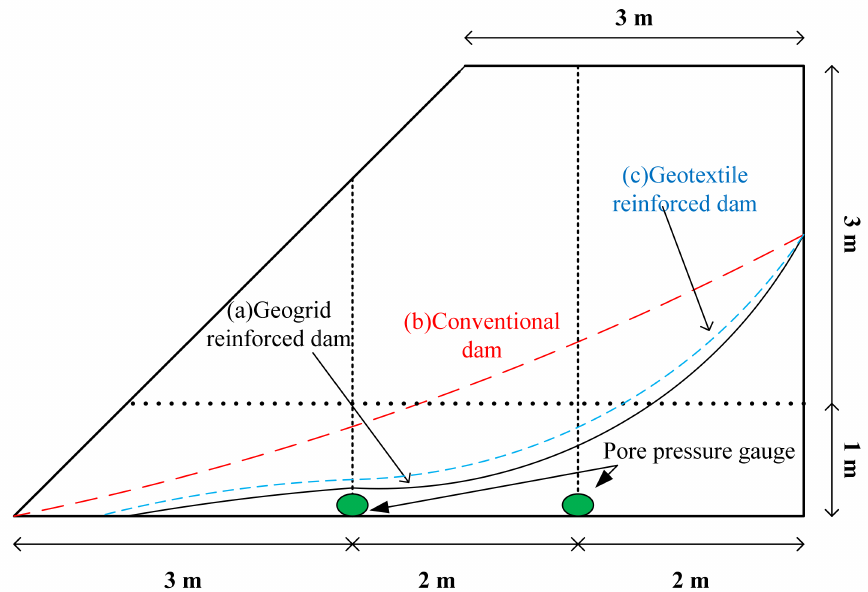
Figure 14. Schematic of the change in the final saturation line of the three test